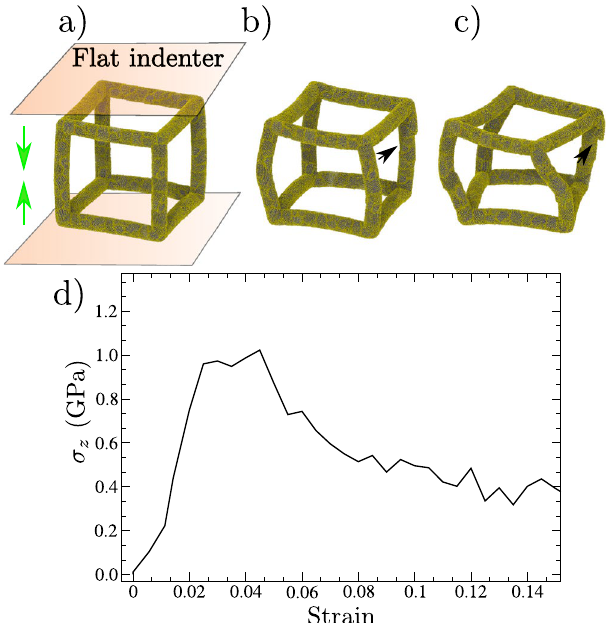
Figure 1. ( a – c ) Show snapshots of the deformed nanoframe at strains of 0.0, 0.05, and 0.15, respectively. Transparent planes represent the flat indenter, while the green arrows depict the displacement direction (z-axis) of both planes. Arrows in ( b ) and ( c ) point to grain boundary displacement events. ( d ) Stress–strain curve obtained from the nanoindentation